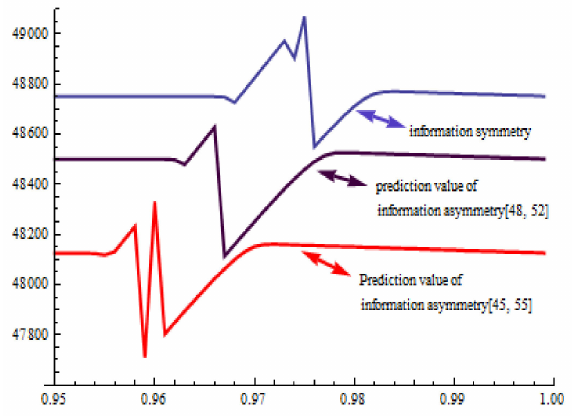
Figure 1. Trend chart of the optimal order